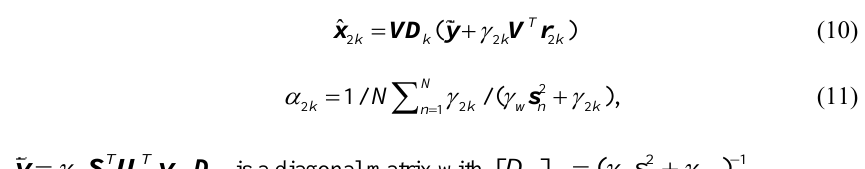
Algorithm 2 VAMP Symbol Detection Algorithm in SC-FDE System